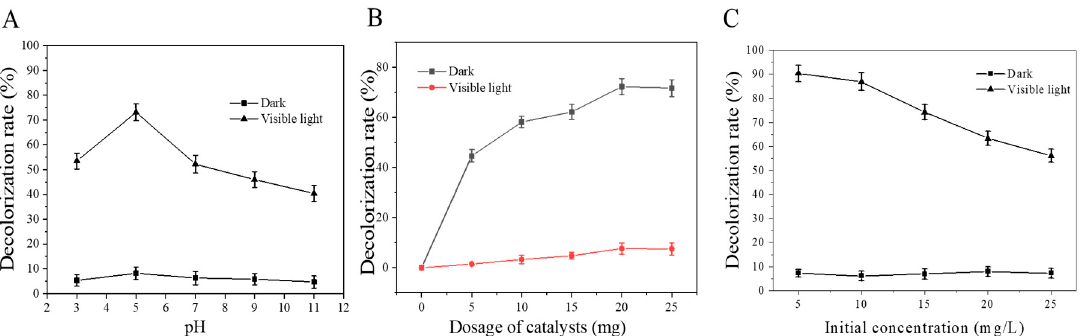
Figure 5. Visible light photocatalytic effect of the TiO 2 /Ag[BMIM]Cl changed with pH ( A ), dosage ( B ) and initial Rh B concentration ( C ).